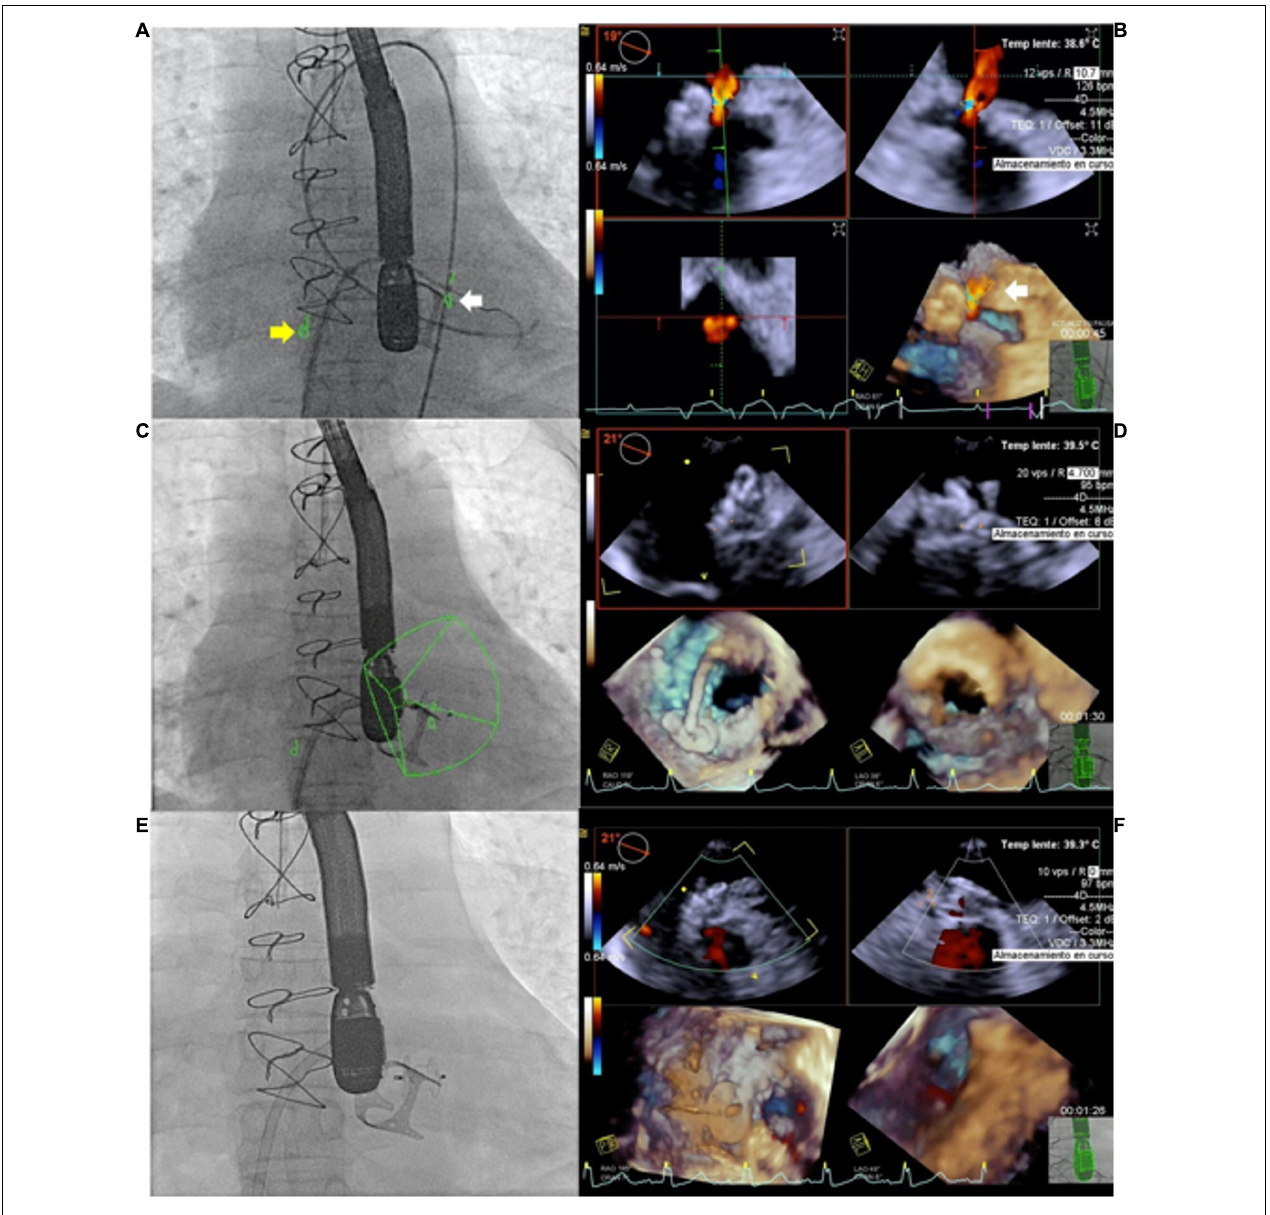
FIGURE 5 | Use of echocardiography-fluroroscopy fusion (EFF) to facilitate mitral paravalvular leak (PVL) closure. (A,B) Anatomical markers placed on fluoroscopy and echocardiography. Marker 1 (yellow arrow) indicate position of transeptal puncture. Marker 2 (white arrow) indicate site of mitral PVL. (B) Color flow Doppler confirming mitral PVL. Combined EFF image allows efficient crossing of PVL (C,D) . Continuous feedback from EFF facilitates alignment of delivery sheath and device deployment. (E) Fluoroscopy showed good device position post release, (F) confirmed by echocardiography and no residual leak was observed. Courtesy of